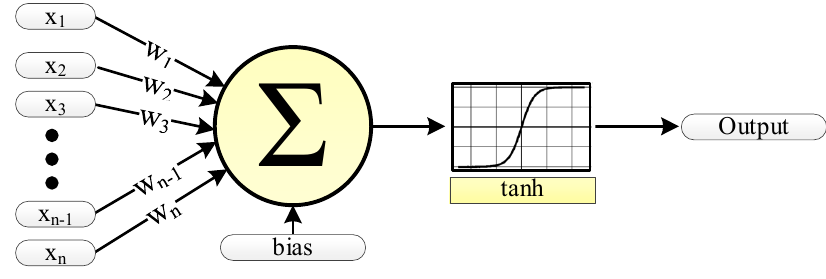
Figure 13. The working flow of each node in the fully connected layer.